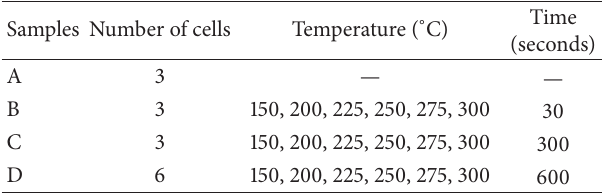
Table 1: Temperatures and time at which cells are exposed. Samples Number of